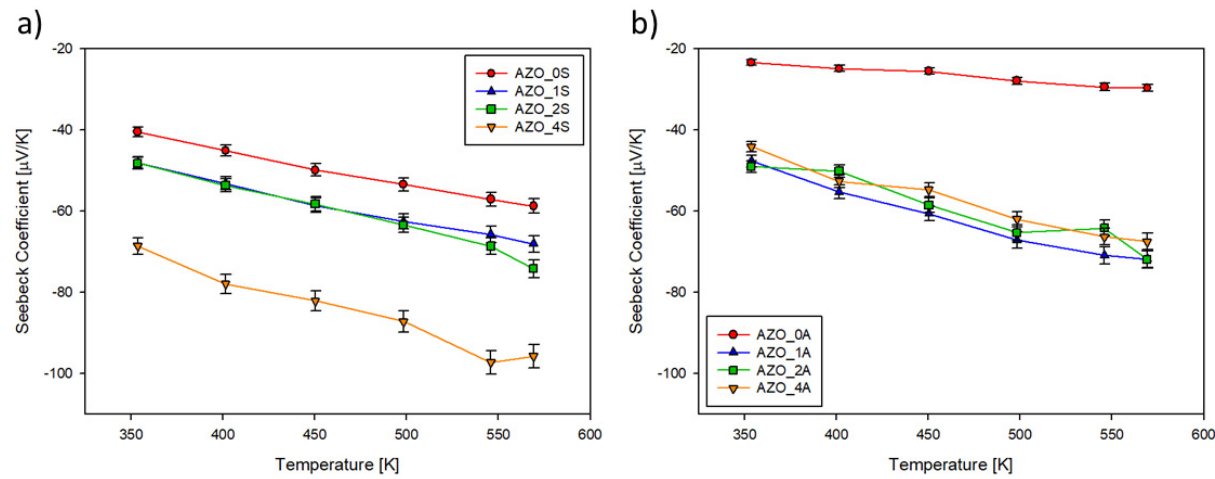
Figure 7. Seebeck coefficient ( S ) plotted vs. temperature of thin films deposited on ( a ) silica (series AZO_xS); ( b ) on Al 2 O 3 (series AZO_xA).